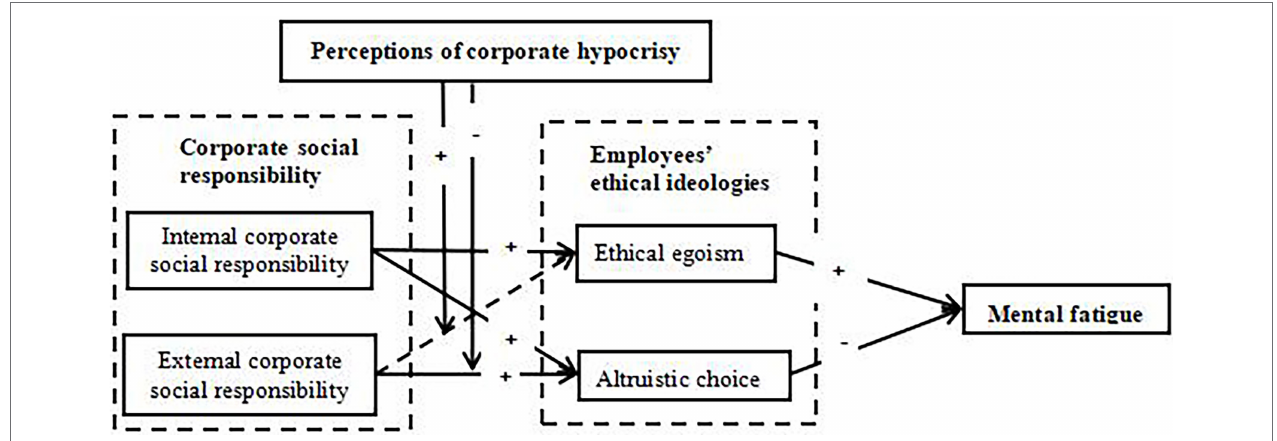
FIGURE 4 | Conceptualization and validation of the study